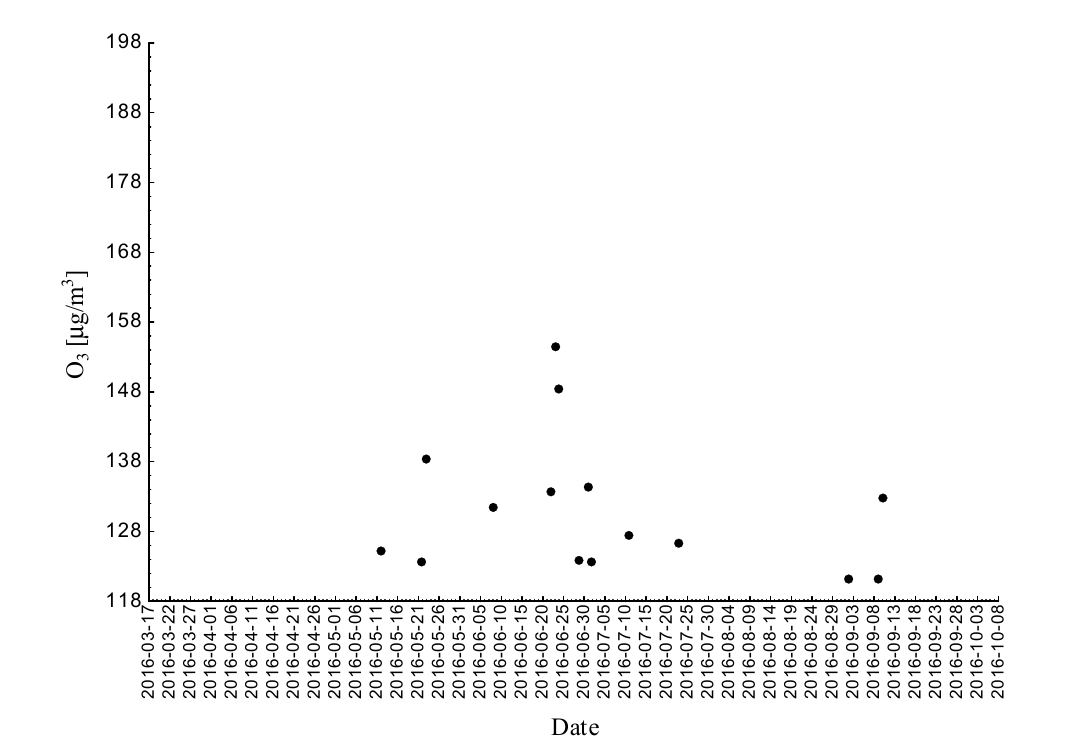
Figure 5. Maximum daily 8-h mean ozone concentration not less (equal to or more than) than 120.4 µg/m 3 registered at the measurement station in Katowice (SL09KA) in 2015.